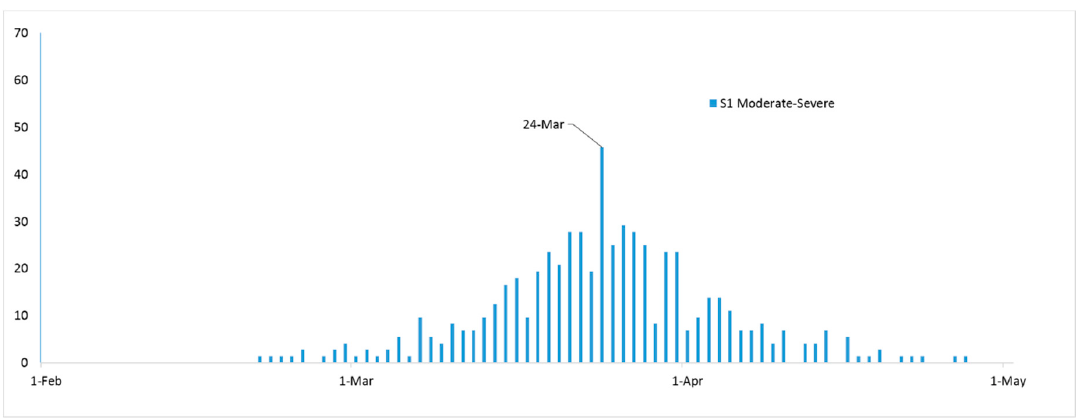
Figure 3. Simulated number of daily new COVID-19 cases in the moderate to severe compartmental state under scenario 1 (S1).